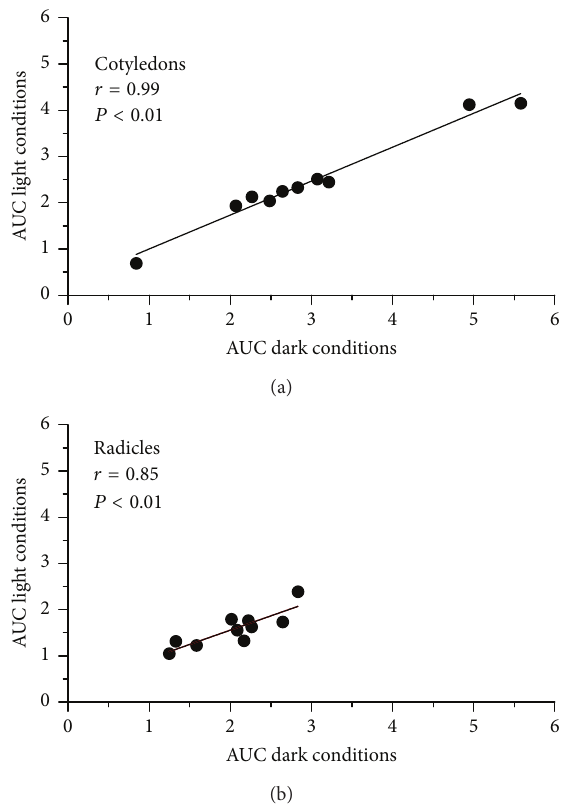
Figure 9: Scatter plots of the area under the curve (AUC, arbitrary units × 10 −3 )oftotaltocopherolcontentfrom1to12daysaftersowing incotyledonsandradiclesoftensunflowerlinesunderdarkandlight